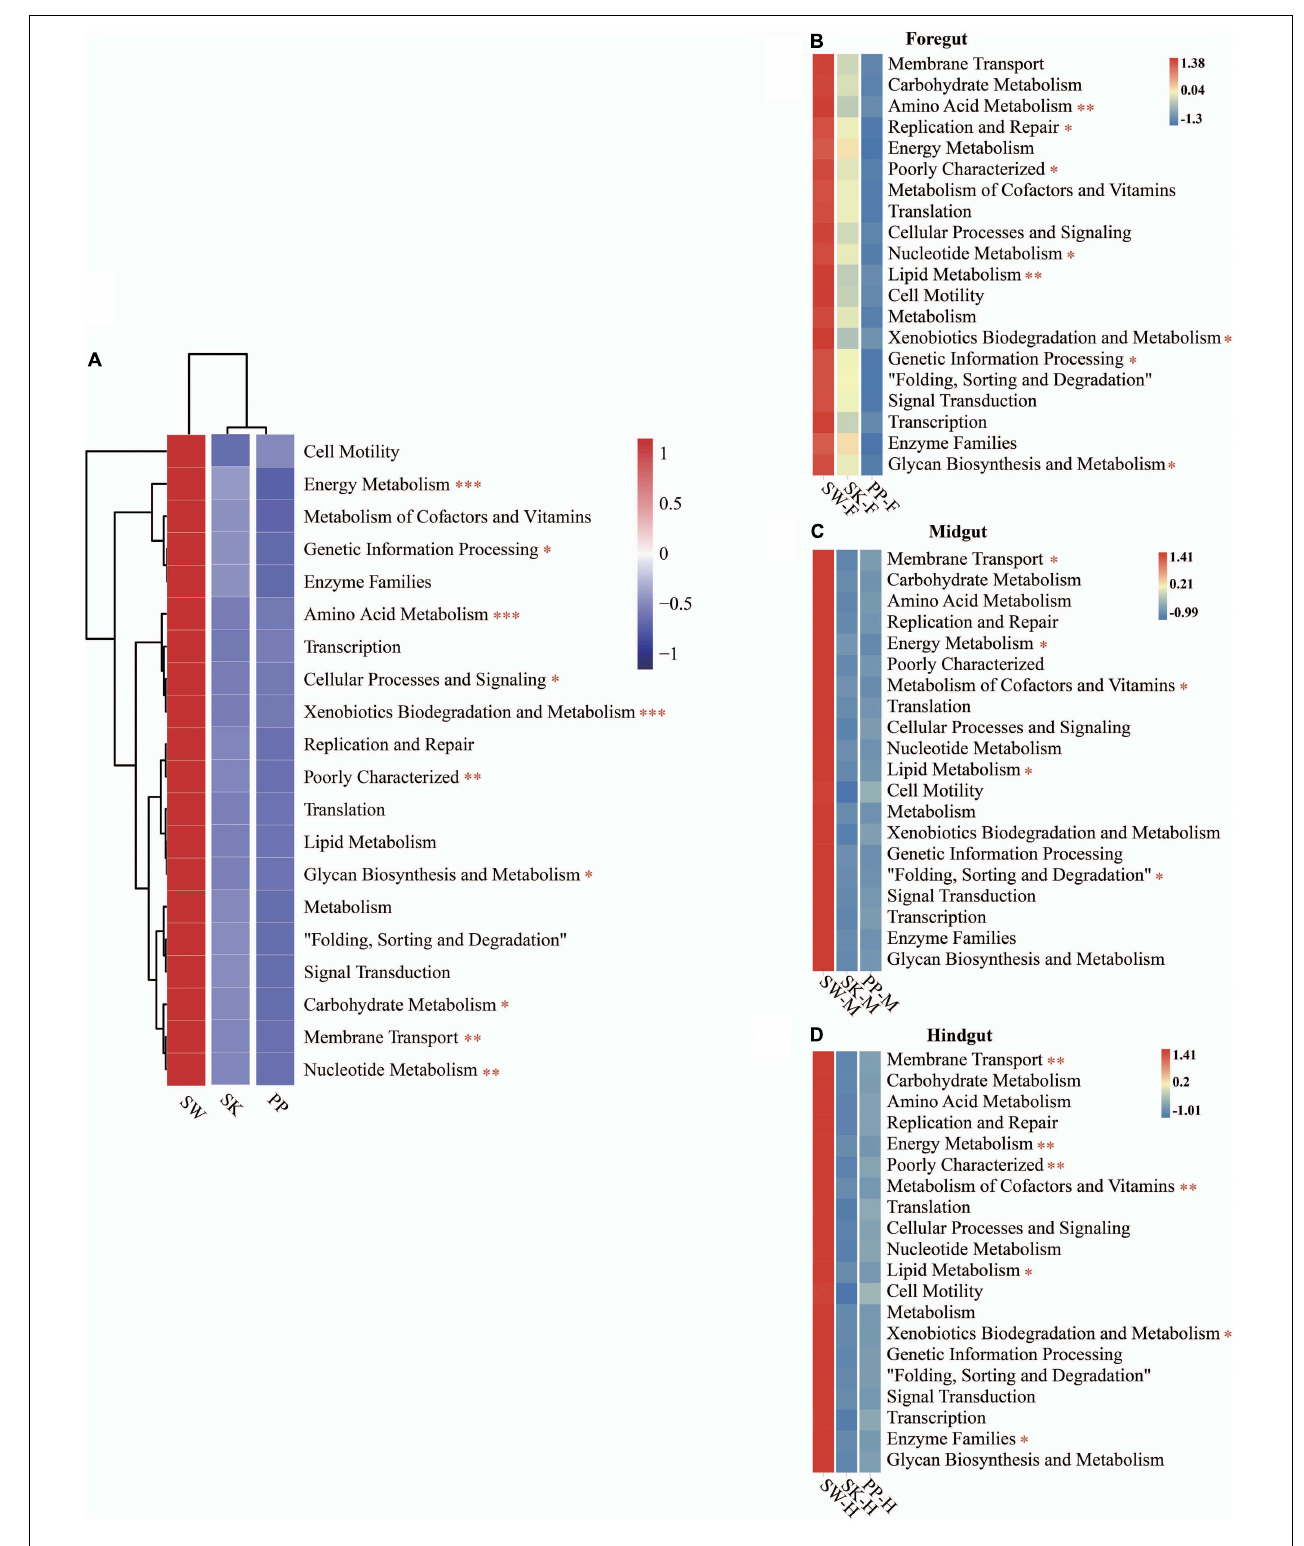
FIGURE 6 | Metabolic functional profiles of the gut microbiome of the three cold-water fishes (KEGG level 2). (A–D) Metabolic functional profiles of the gut microbiome of all species, S. wangchiachii , S. kozlovi , and P. pingi among different intestinal sections. F, foregut; M, midgut; H, hindgut. The one-way analysis of variance (ANOVA) was used to identify significant differences between different samples. ∗ p < 0.05; ∗∗ p < 0.01; ∗∗∗ p < 0.001.